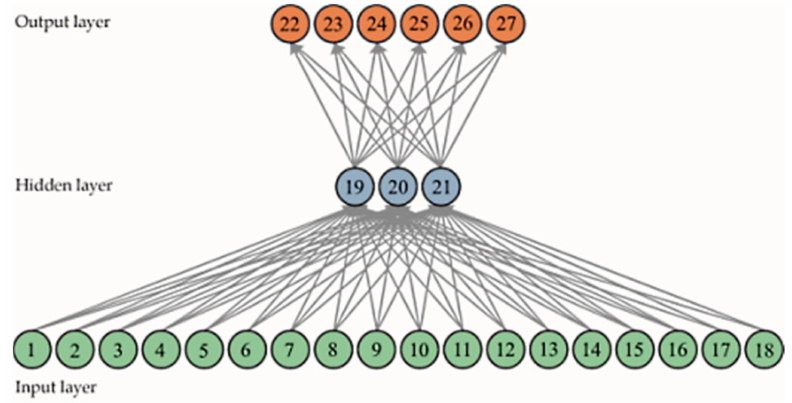
Figure 6. Neural network structure.